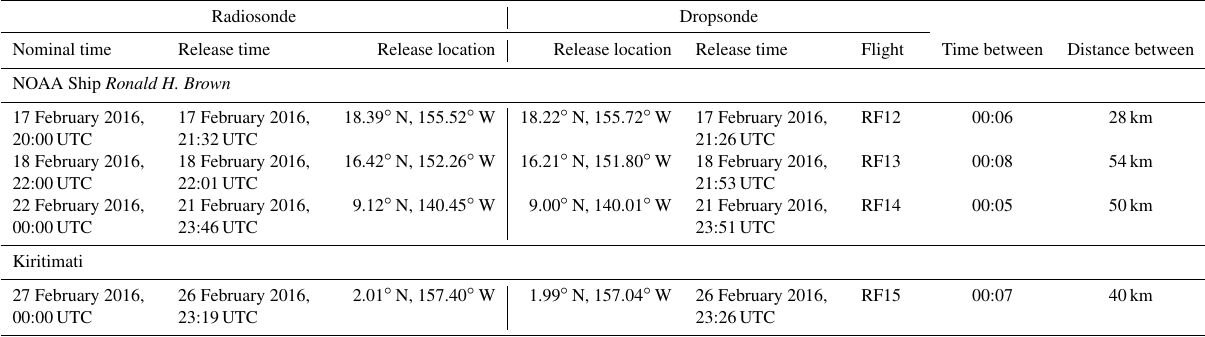
Table 1. Coordinated soundings during the ENRR Field Campaign. Radiosondes were launched from either the ship or the island, and dropsondes were released from the NOAA Gulfstream-IV (G-IV). The horizontal distance between launch points was calculated using Great Circle navigational formulae by the NOAA/National Hurricane Center calculator at http://www.nhc.noaa.gov/gccalc.shtml. Radiosonde Dropsonde Nominal time Release time Release location Release location Release time Flight Time between Distance between NOAA Ship Ronald H.